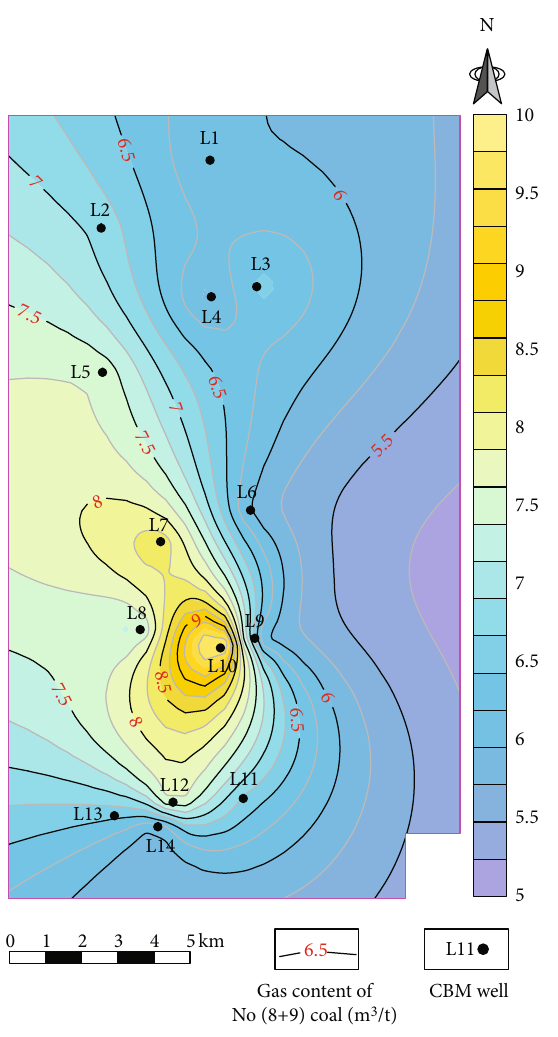
Figure 6: Contour map of gas content of No. ( 8 + 9 ) coal in Yangjiapo block.